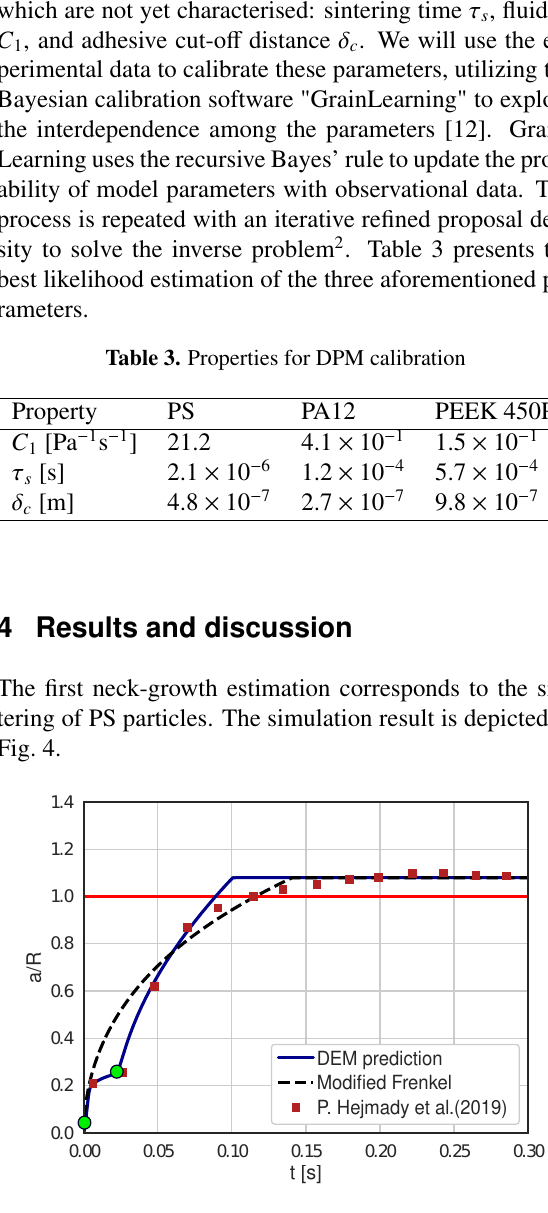
Figure 4. sintering curve of Polystyrene particles, R = 30 . 0 µ m compared with Frenkel’s model (dashed line), and experimental data (boxes)